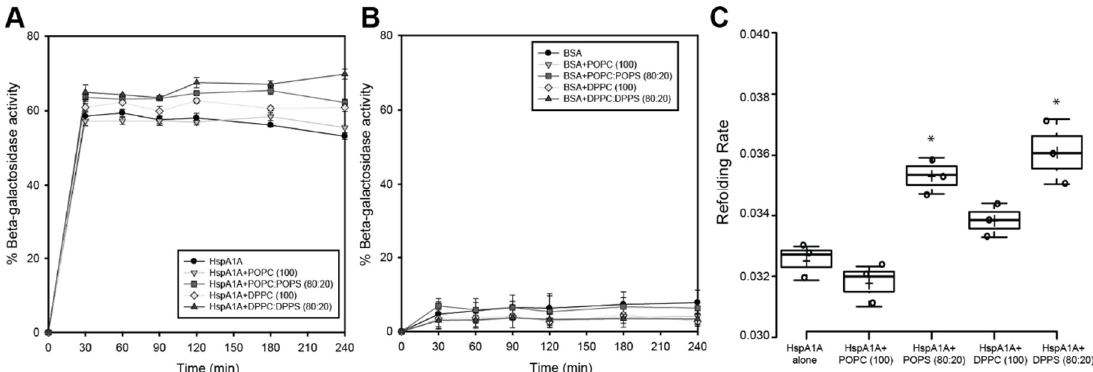
Figure 4. The binding to phosphatidylserine results in a small but consistent increase of the refolding activity of HspA1A. In these experiments, β-galactosidase was chemically denatured and the recovery of the enzyme’s activity was determined by hydrolysis of ortho-nitrophenyl-β-galactoside as compared to the activity of the native enzyme. ( A ). The data are plotted as percent of activity based on the activity of the native β-galactosidase; ( B ) BSA and reactions with no enzyme were used as negative controls; ( C ) The refolding rate was calculated by using the linear regression line of all time points. A p -value < 0.05 is denoted with a *. The p -values of the statistical tests are provided in Supplementary Table S1.